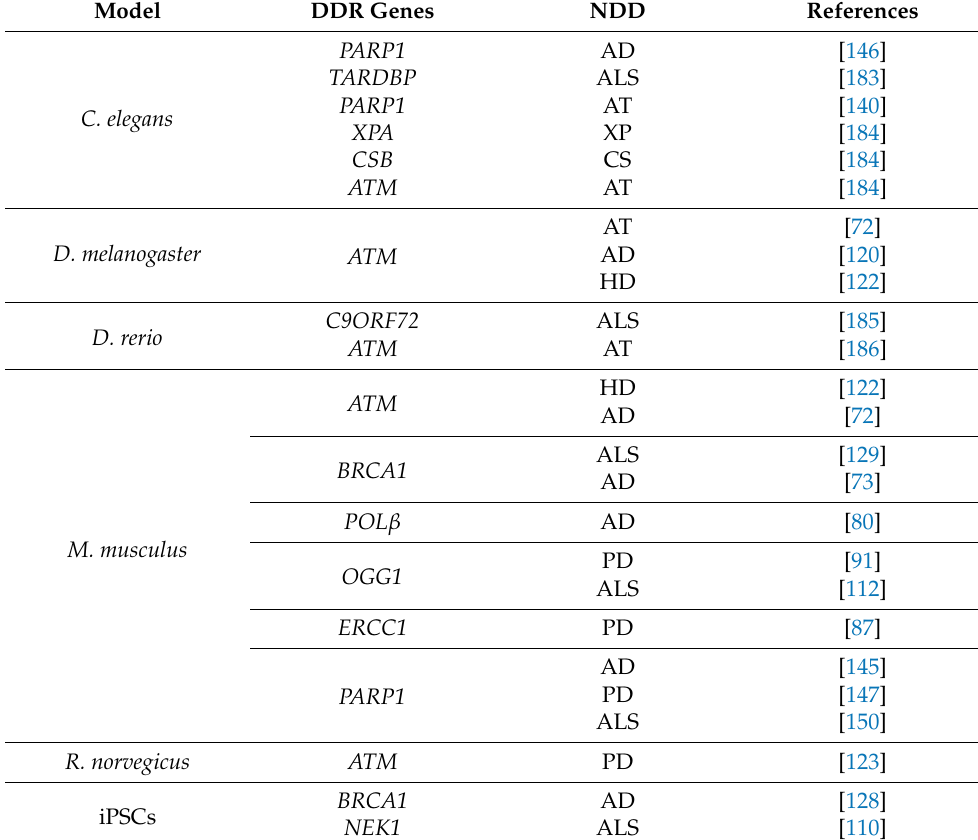
Table 1. Different model systems to study NDDs and the involvement of DDR. The table shows various model systems that have been used to study the role of DDR in various NDDs. Xeroderma Pigmentosum, CS: Cockayne